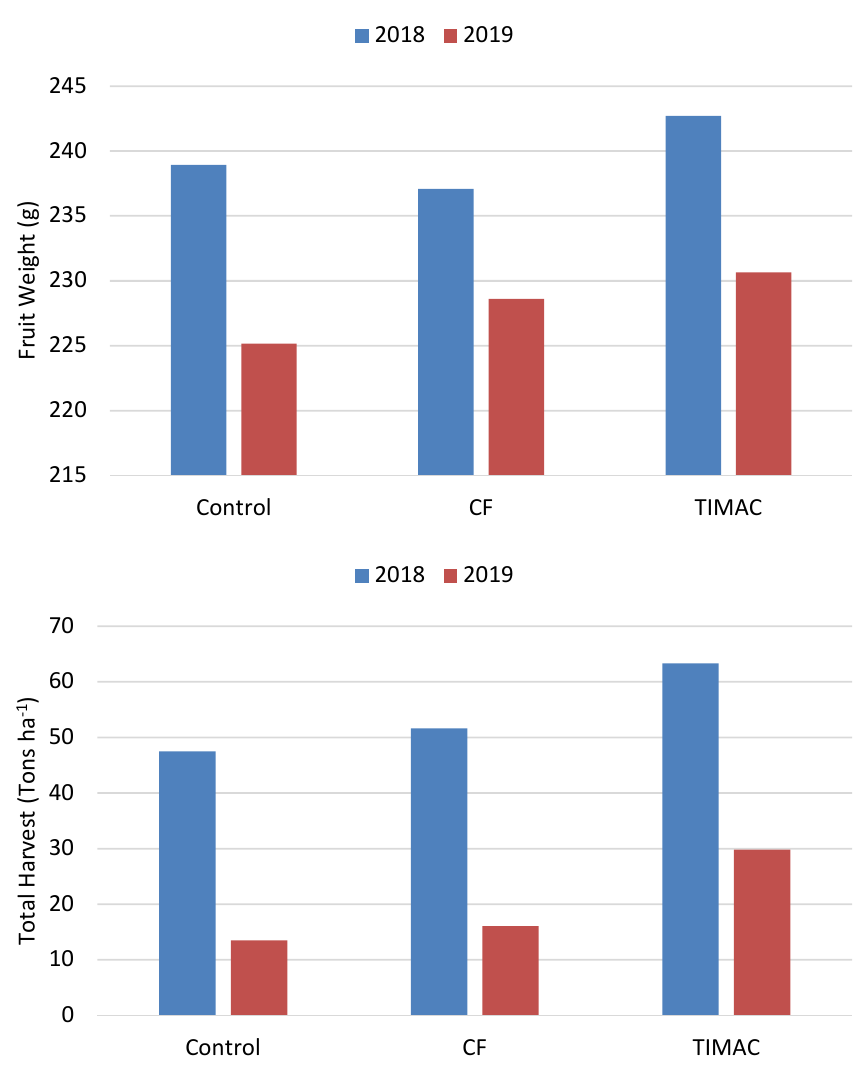
Figure 3. Improvement of fruit weight ( top ) and total harvest ( bottom ) under TIMAC treatment.